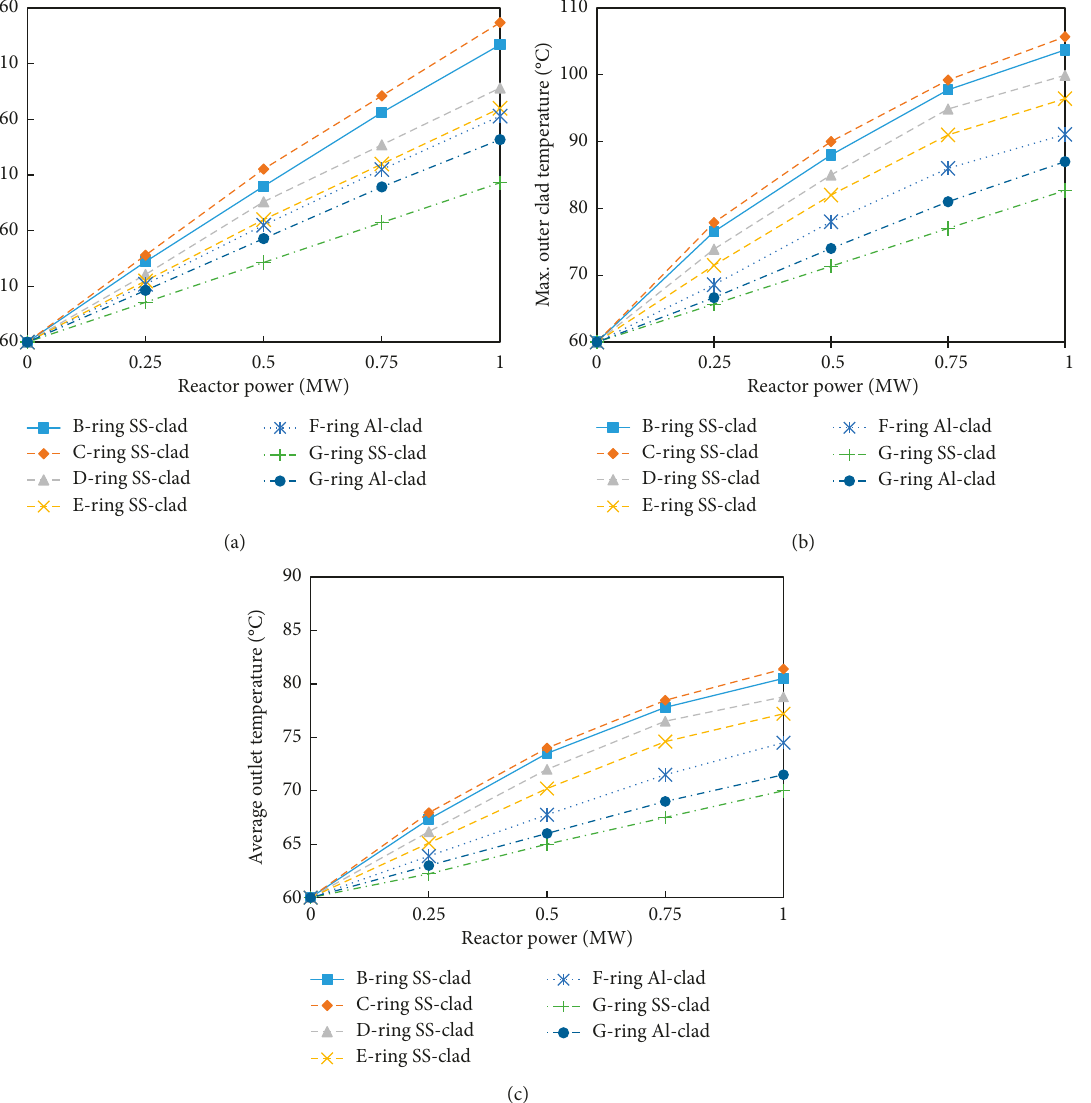
Figure 16: Predicted, (a) fuel, (b) outer clad, and (c) outlet temperatures in each fuel ring versus the reactor